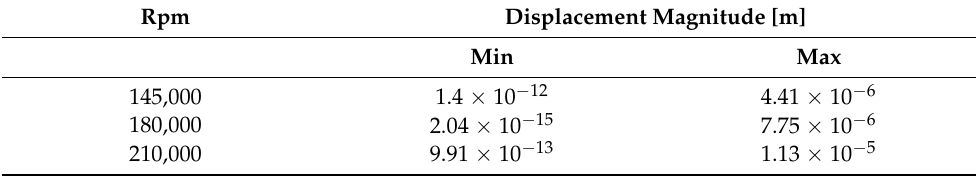
Table 8. Displacements results.